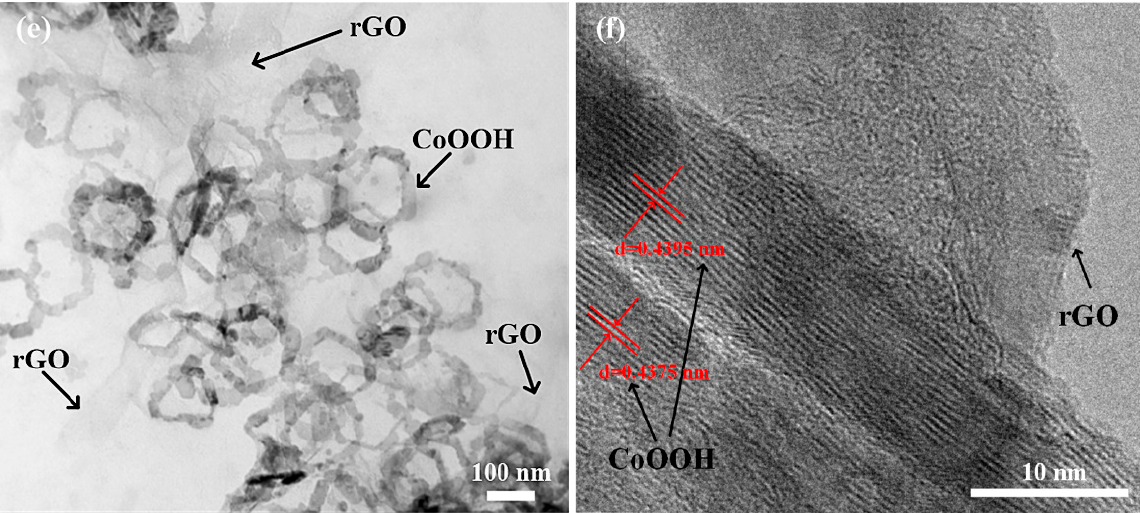
Figure 2. ( a ) TEM and ( b ) SEM images of pure CoOOH. ( c , d ) SEM images of CoOOH/rGO at different magnifications. ( e , f ) TEM images of CoOOH/rGO at ( e ) low magnification and ( f ) high magnification.